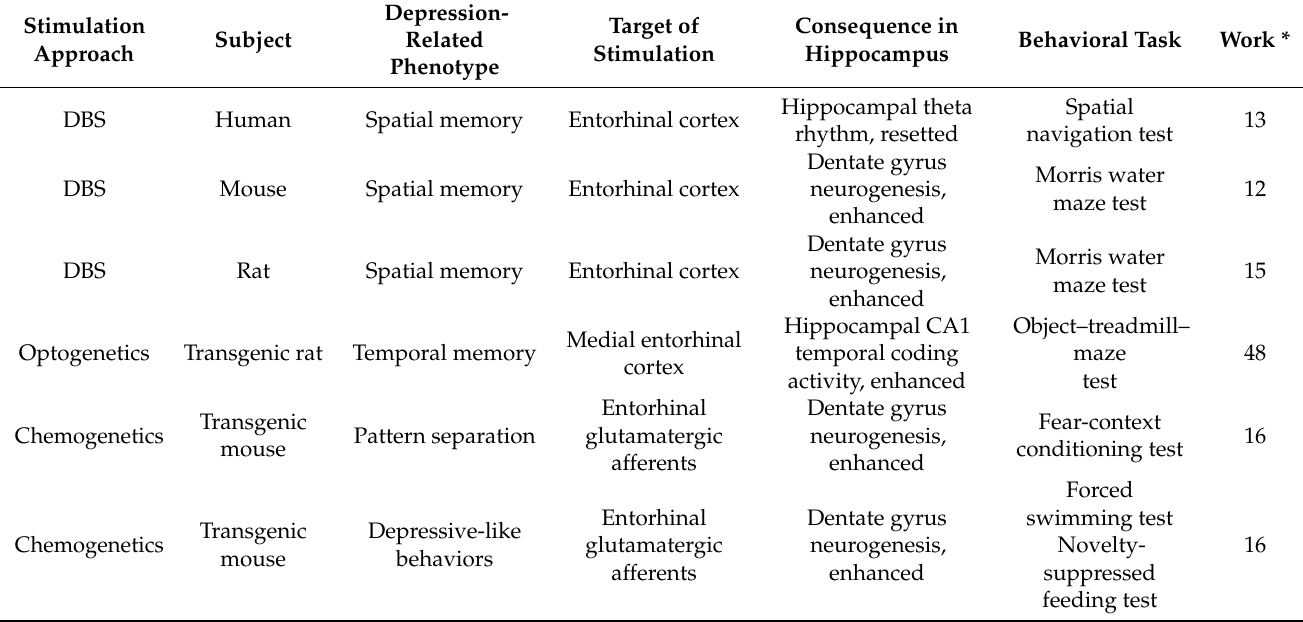
Table 1. Representative works elucidating the casual relationship between entorhinal–hippocampal circuitry and neurogen- esis and depression-related